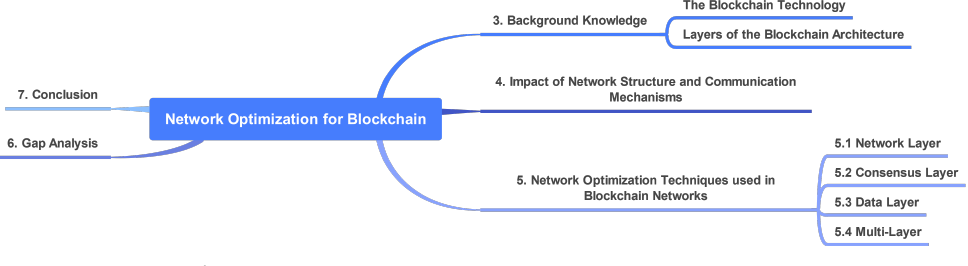
Figure 1. Structure of